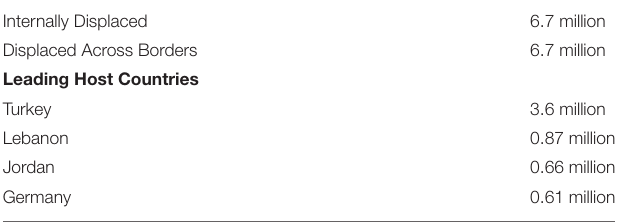
TABLE 3 | Forcibly displaced